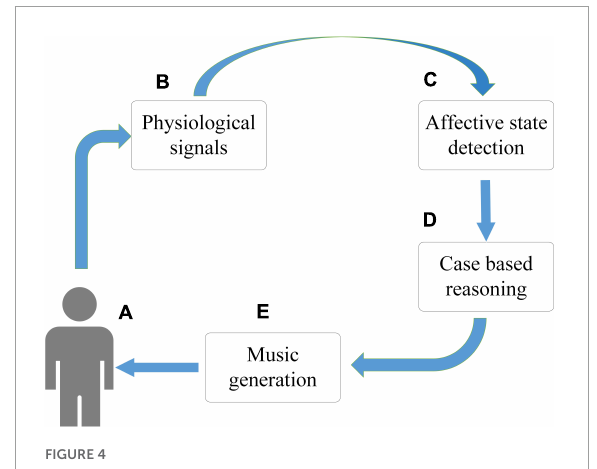
FIGURE4 The proposed affective brain-computer music interface (aBCMI). The system consists of five key elements: (A) . The user of the system (B) . The user’s physiological signal acquisition module (including the electroencephalogram (EEG), electrocardiogram (ECG) and respiration rate) (C) . An emotional state detection system for identifying a current emotional state that a user is experiencing (D) . A case-based reasoning system that determines how a user moves from his current emotional state to a new target emotional state (E) . The music generator is used to play music for the user. The case-based reasoning system identifies the most appropriate emotional trajectory and moves them to the target emotional